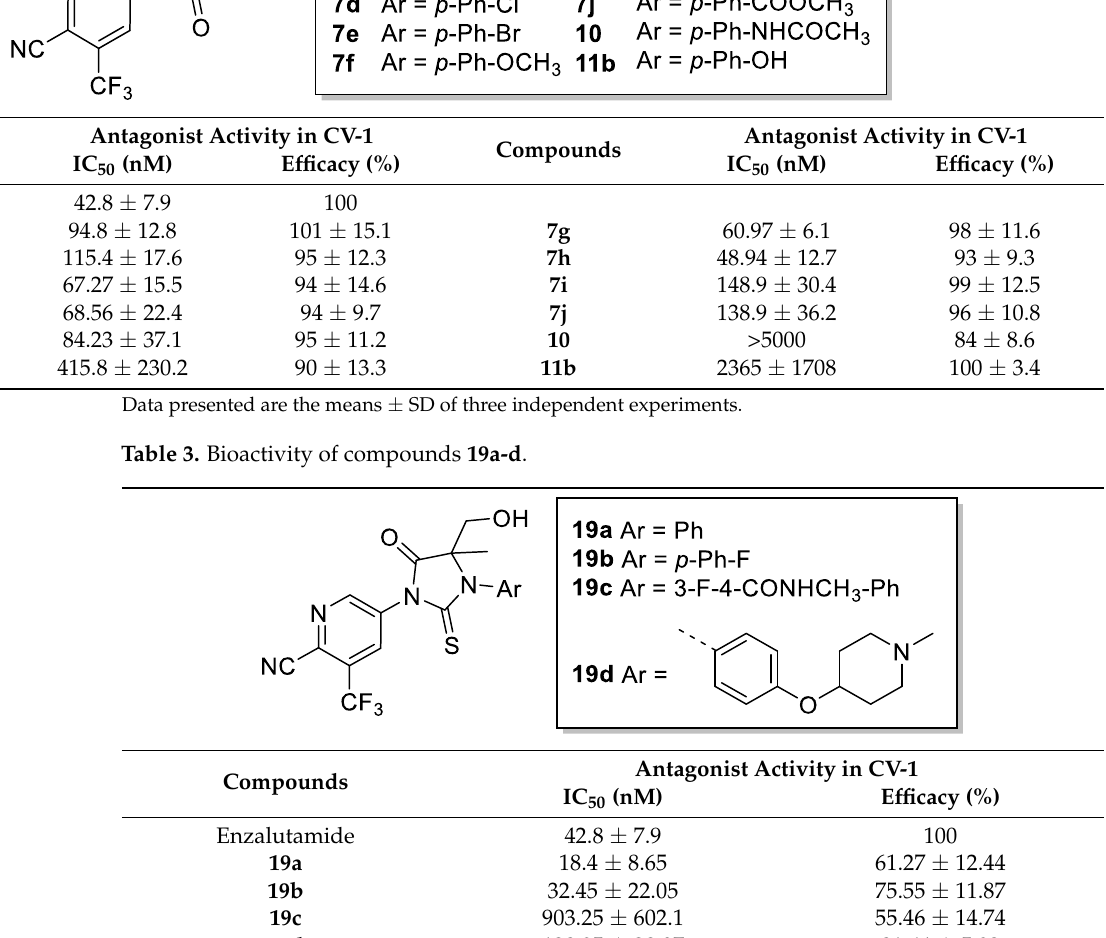
Table 3. Bioactivity of compounds 19a-d .